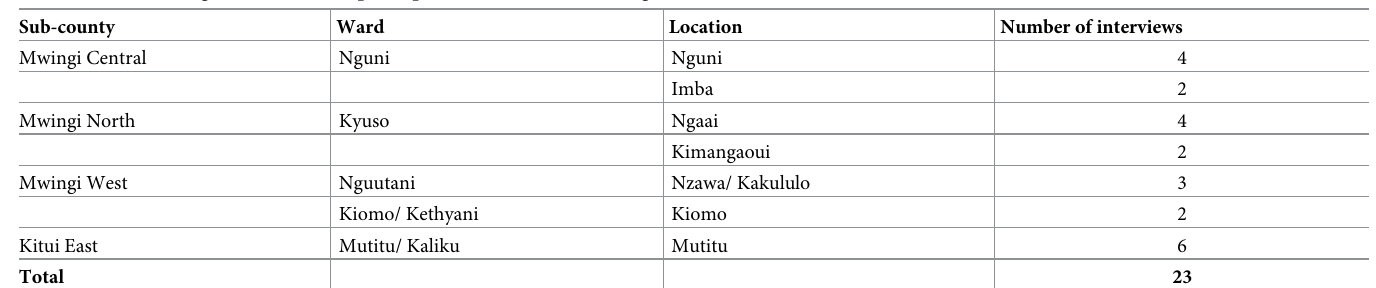
Table 1. Selected villages and number of participants recruited in each